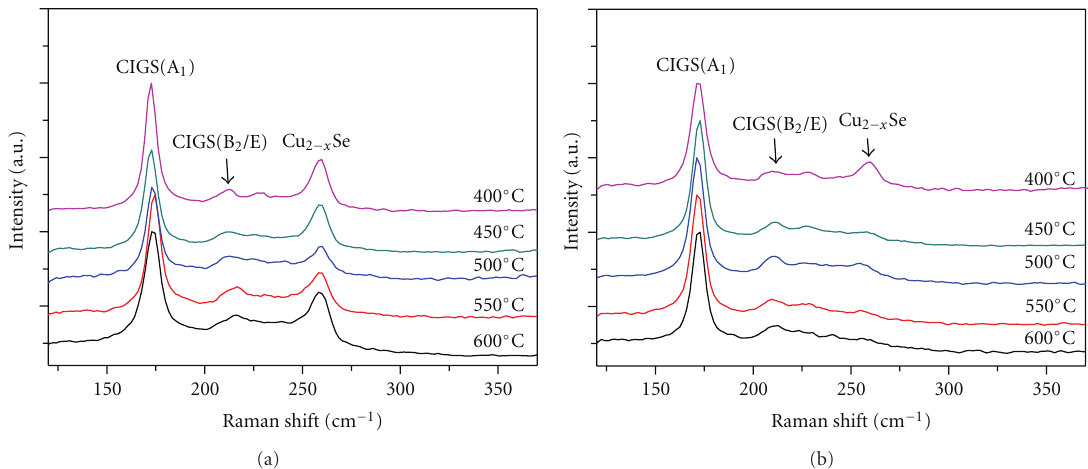
Figure 3: Raman spectra of CIGS films selenized at di ff erent selenization temperatures for 30 min from (a) Cu-rich precursor films, and (b) Cu-poor precursor